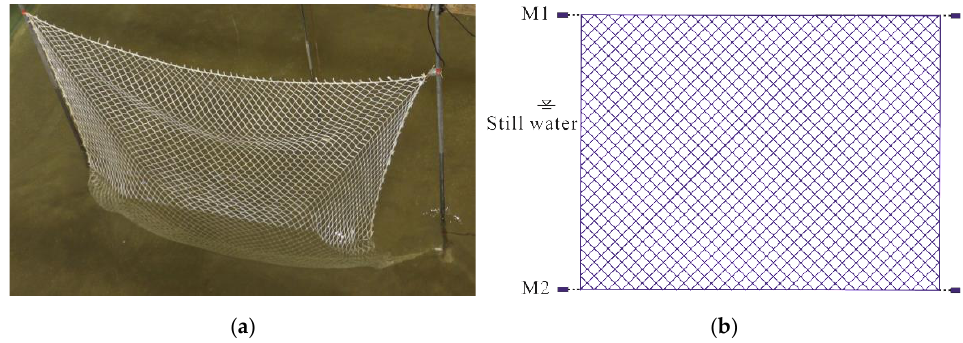
Figure 4. Setup of a net panel and four-point mooring system in current ( a ) experimental test; and ( b ) numerical simulation.